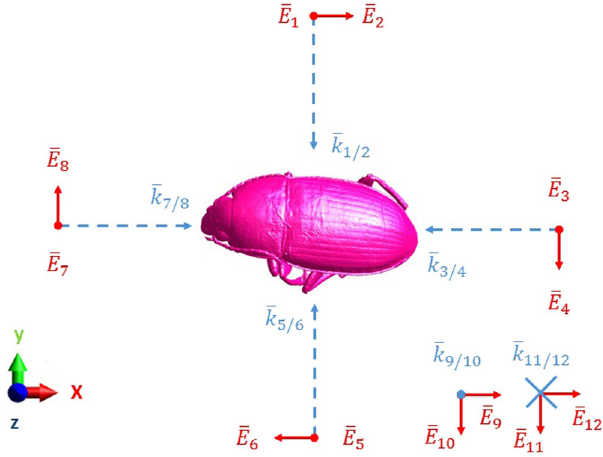
Figure 1. Illustration of the RF-EMF exposure set up. The insect (Beetle shown here in pink) is exposed to twelve RF plane waves incident from six directions along the positive and negative directions of the Cartesian axes shown on the bottom left with two orthogonal polarizations for each direction. The twelve wave vectors k are indicated in blue (dashed arrows), while the polarization of the incident electric fields E i and j indicate the configuration number, from 1 to